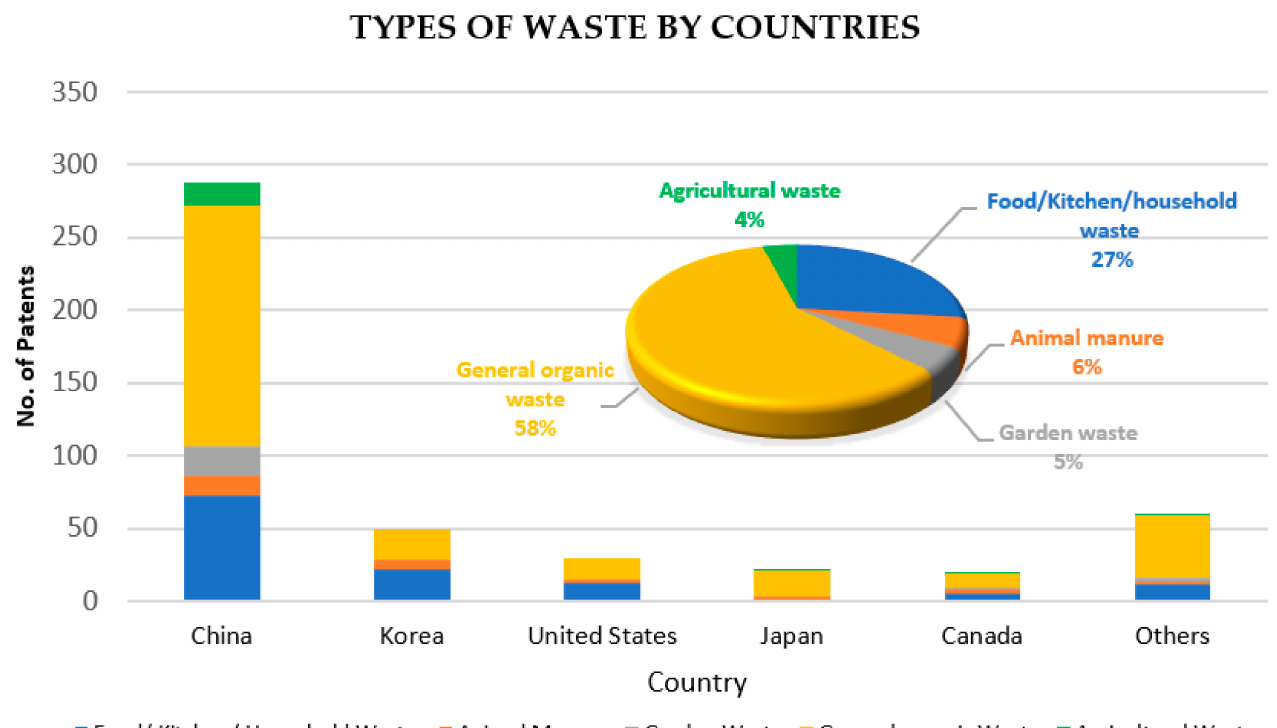
Figure 9. Types of waste by countries and the respective compositions of the waste